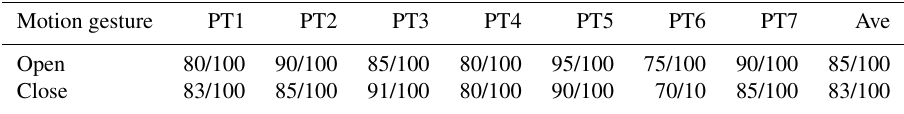
Table 3. Results of testing the hand on seven